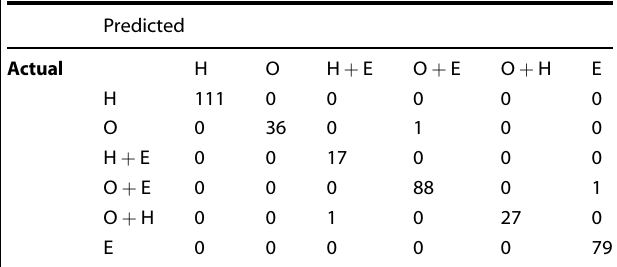
Fig. 8 Performance of the machine learning algorithm. The comparison of ground truth total conductivities (along the x -axis) with predicted total conductivities for test set (10%) and cross- validation set (5%) with error bars. The root mean-squared error (RMSE) in prediction of the test set is 0.24, while that of the cross- validation set is 0.25. Table 2. Confusion matrix for the cross-validation set (5% of the total data) for charge carrier